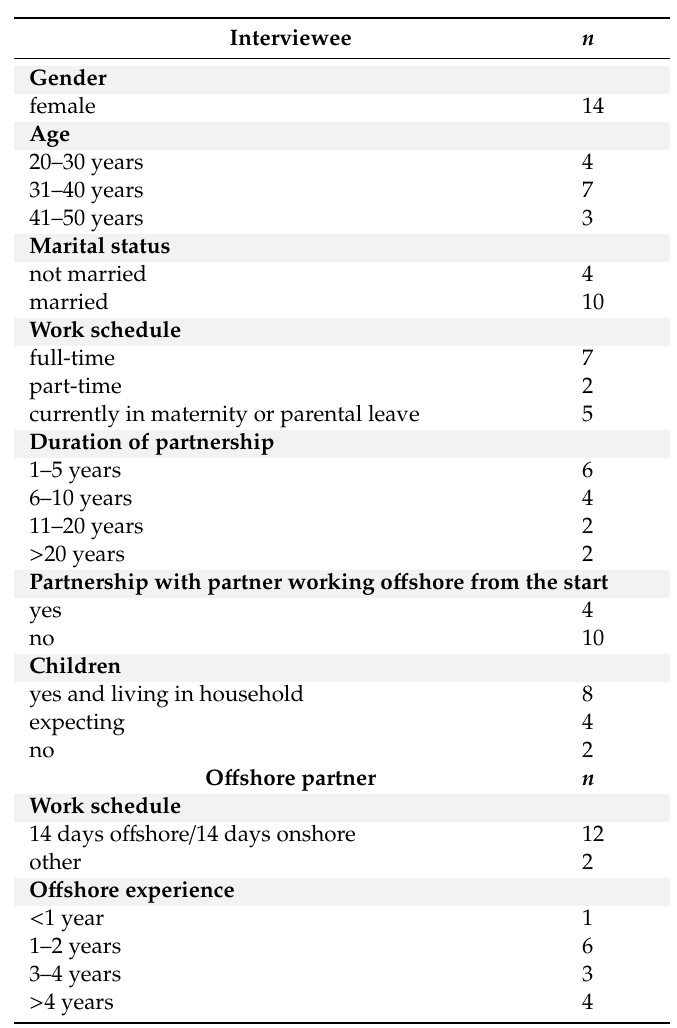
Table 2. Participant